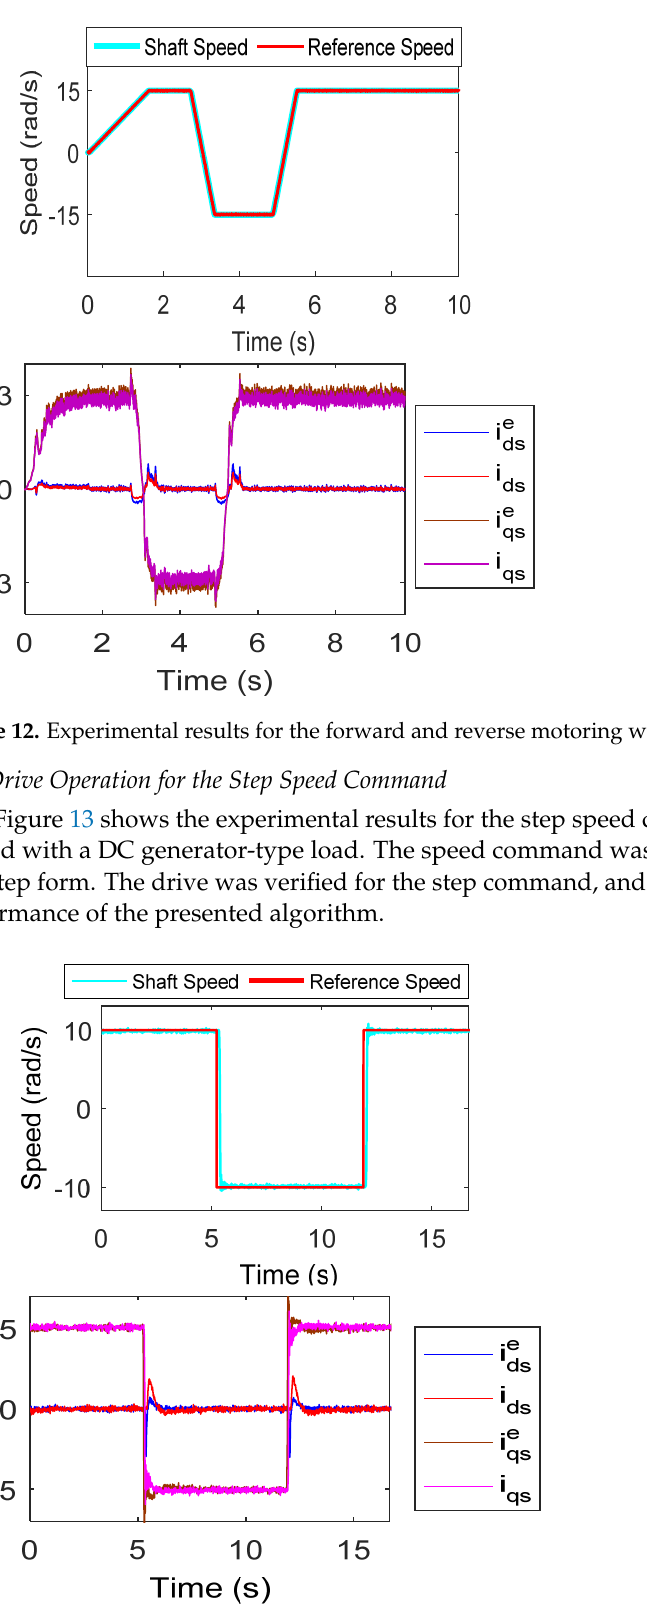
Figure 13. Experimental results for the step speed command.